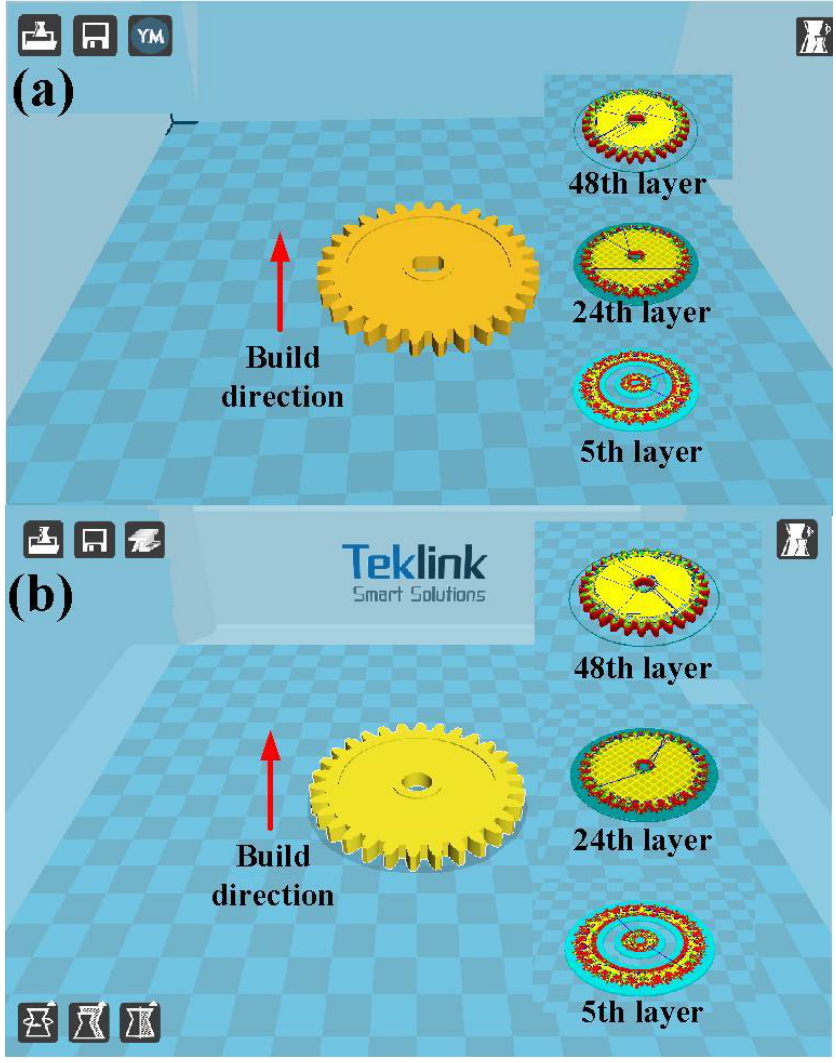
Figure 3. 3D printing software interface of ( a ) driving gear and ( b ) passive gear. Table 1. Main numerical modeling parameters used in the numerical analysis.